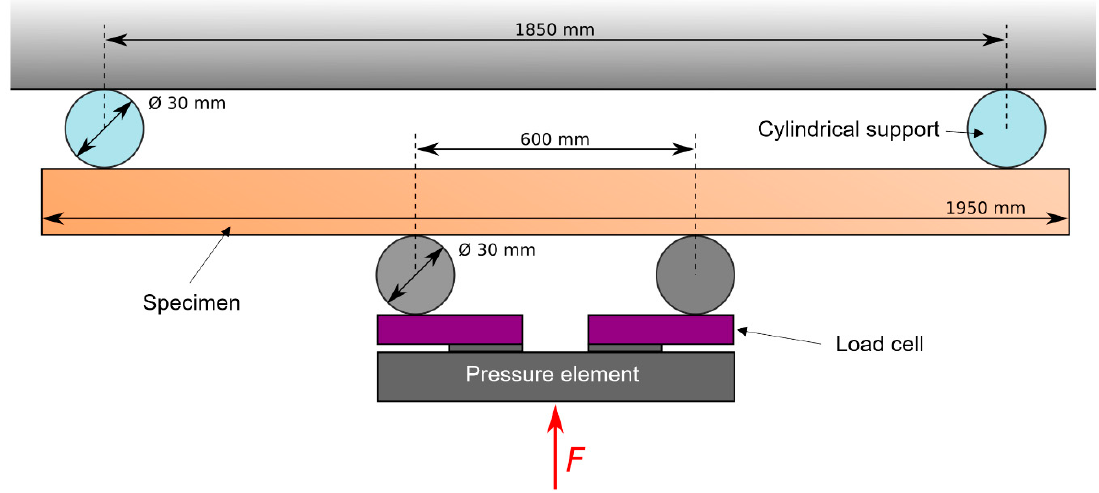
Figure 12. Software interface.